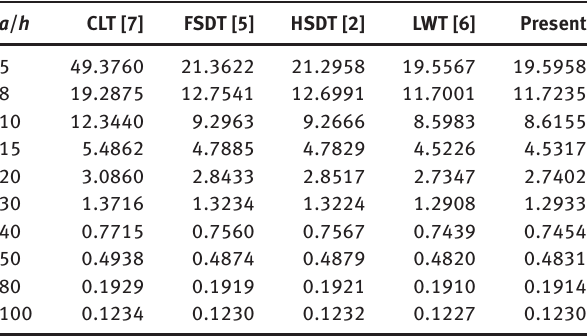
Table 3: Comparison of critical buckling temperature T simply supported square laminates with different side-to-thickness ratios.